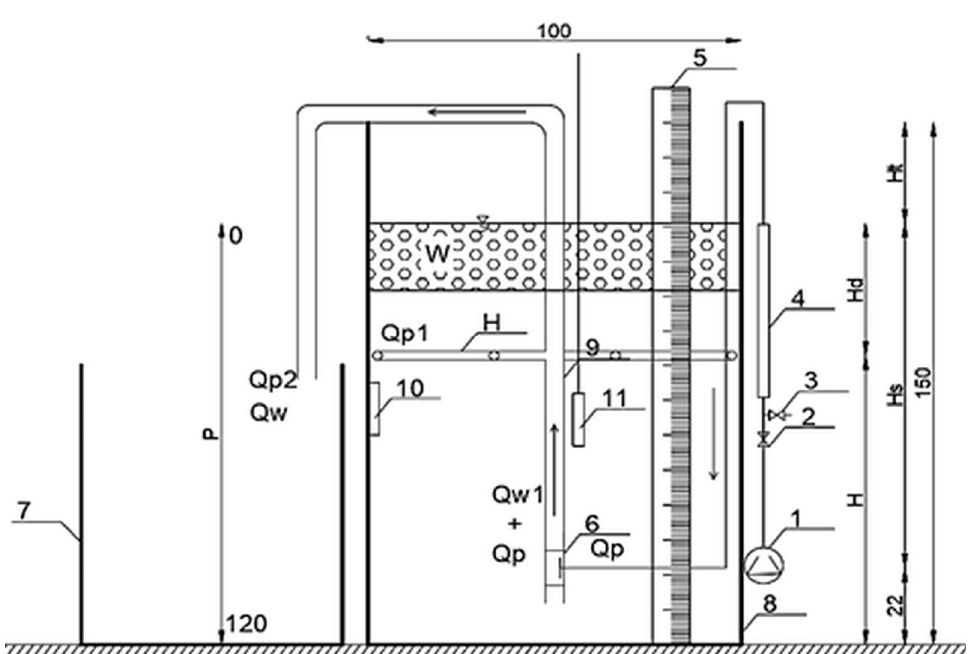
Figure 1. Scheme of the installation: 1—air blower, 2—control valve, 3—blow off valve, 4—rotameter, 5—scale, 6—diffuser, 7—recirculation tank, 8—main tank, 9—airlift pump with nozzle, 10—hydrostatic liquid level sensor, 11—liquid dissolved oxygen sensor (LDO), Qp—supply air flow rate,